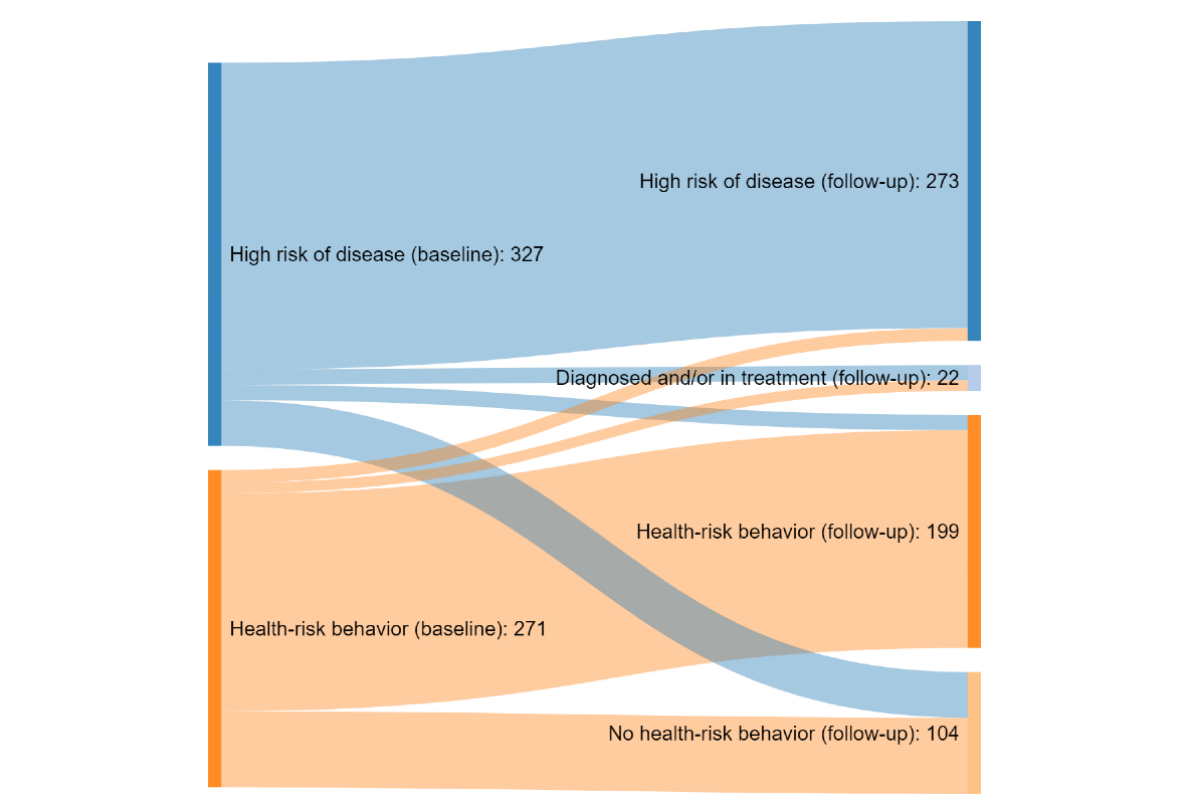
Figure 2. Participant change in risk status from baseline to 1-year